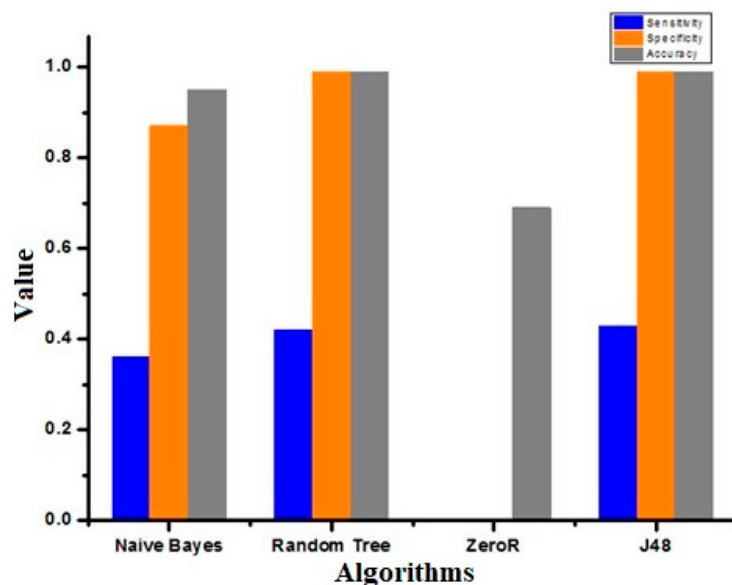
Figure 15. Graphical representation of sensitivity, specificity, and accuracy of different algorithms.